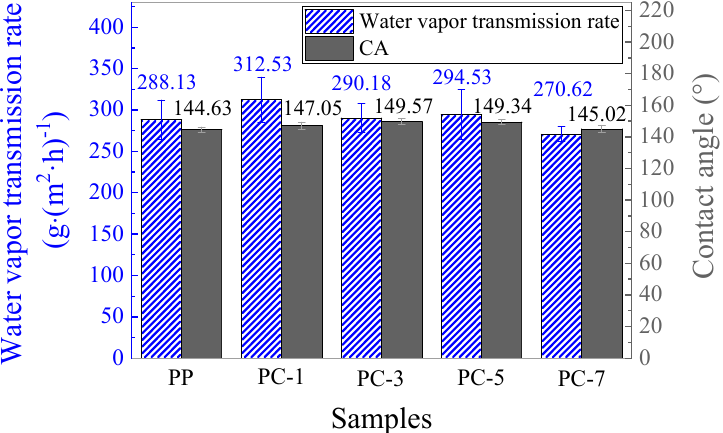
Figure 16. Moisture permeability and water contact angle of the PP meltblown membranes with